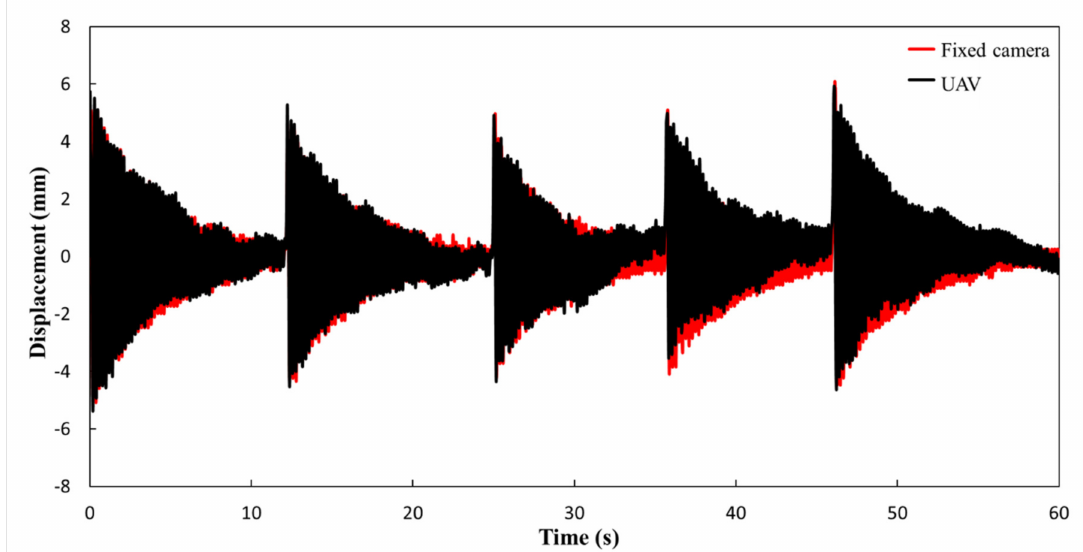
Figure 8. Comparison of recorded signal from fixed camera and UAV (corrected).